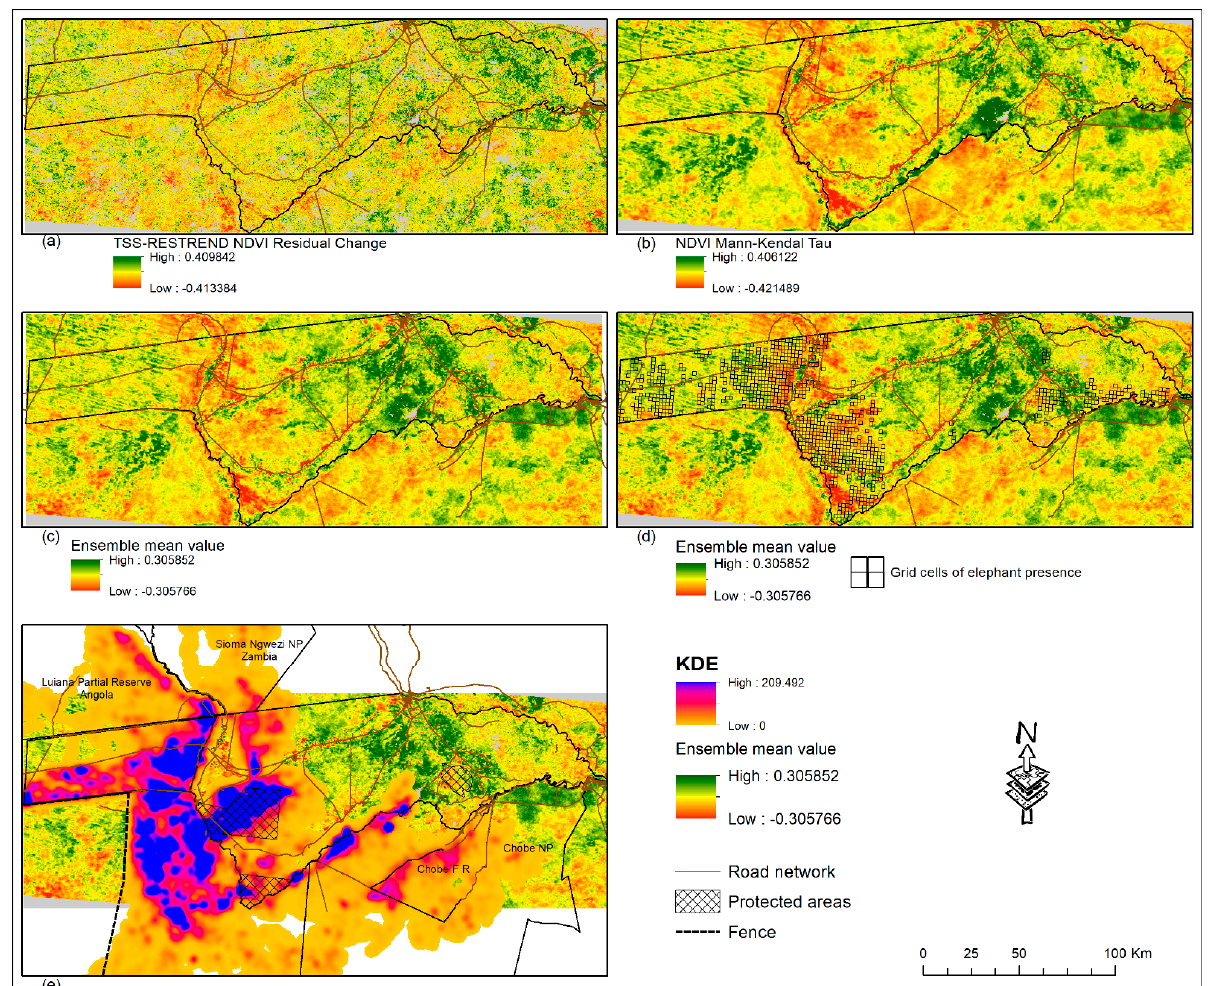
Figure 2. ( a – e ) show the output of the TSS.RESTREND, Mann–Kendall, ensemble, and kernel density estimate (KDE) analysis over the whole Zambesi region. In ( a ), the Residual Change of the TSS.RESTREND and ( b ) is the Mann–Kendall Tau. In ( c ) is the ensemble of the mean values of RESTREND, TSS.RESTREND, ( d ) the spatial distribution of elephant sightings overlayed over the ensemble mean value from ( b ) above and ( e ) the overlay of the Kernel Density Estimate (KDE), and Mann-Kendal Tau from ( b ) above. No data and background values are displayed as grey.